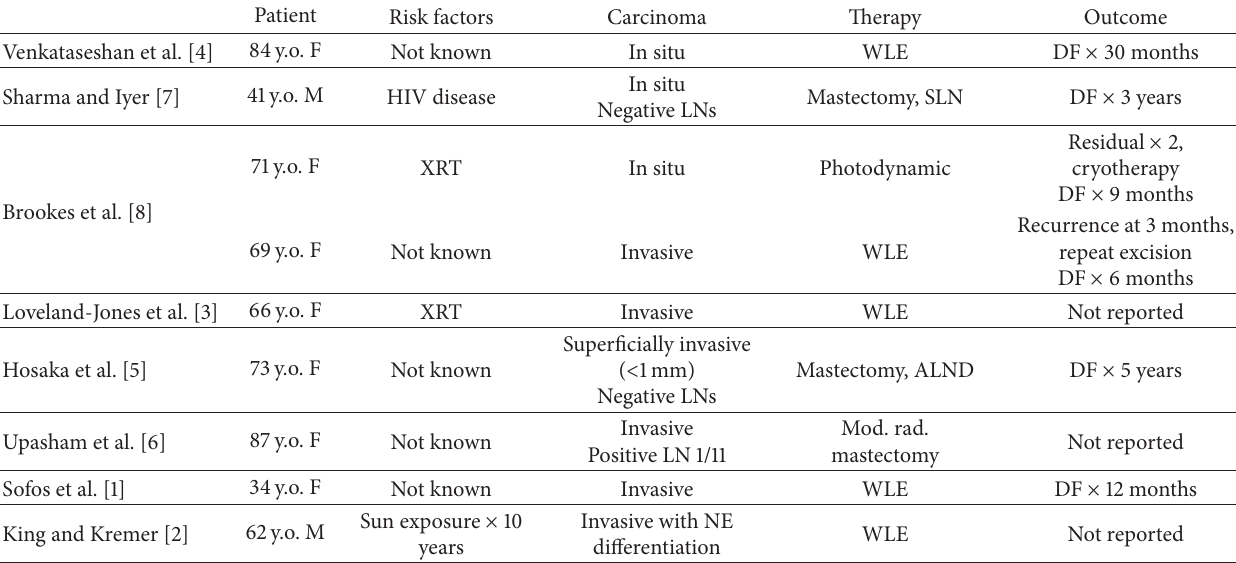
Table 1: Case reports, squamous cell carcinoma of the nipple and areola.